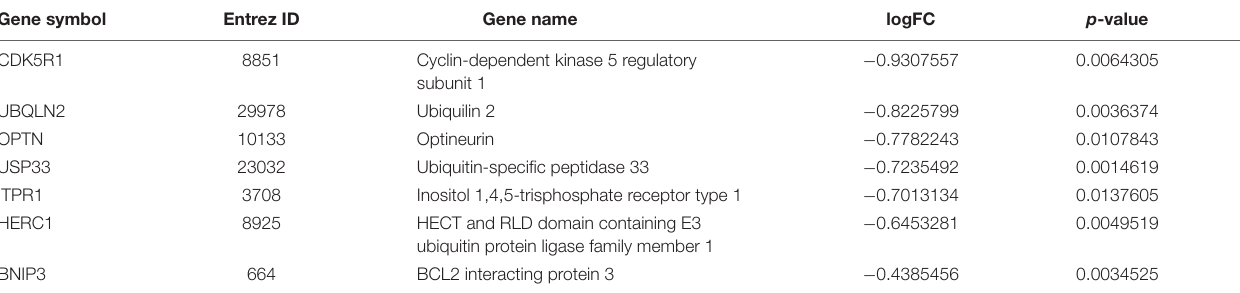
TABLE 4 | The expression of autophagy-related genes with significant differences in black